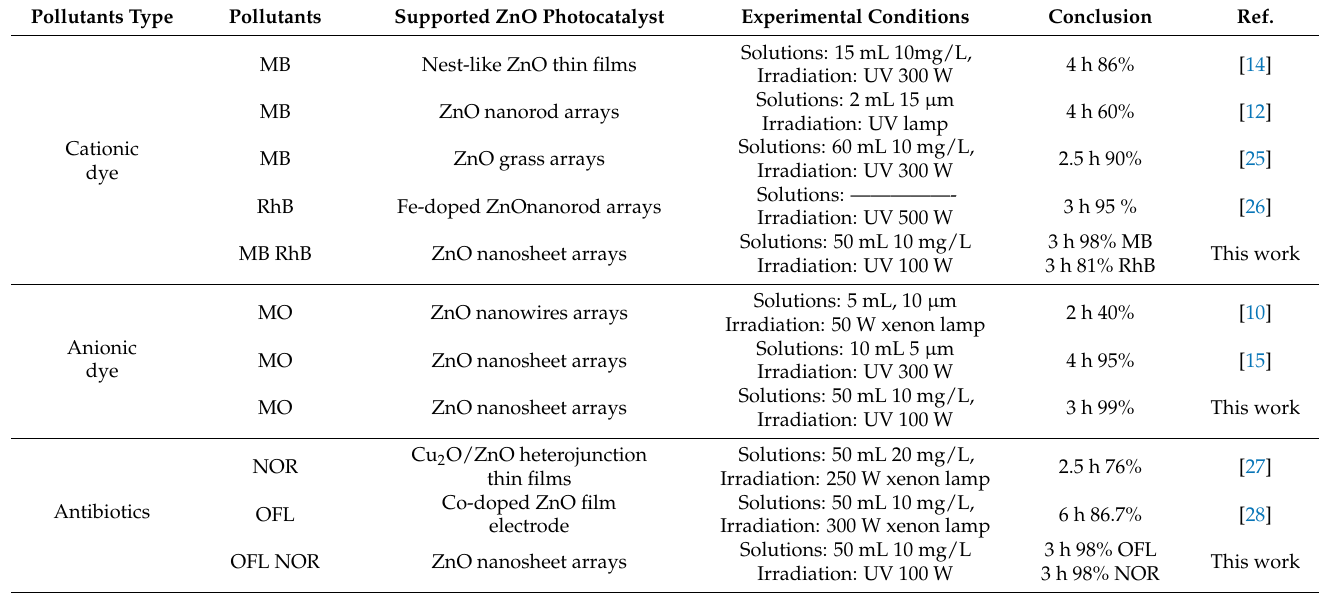
Table 2. Comparison of the degradation of various pollutants between this work and previous